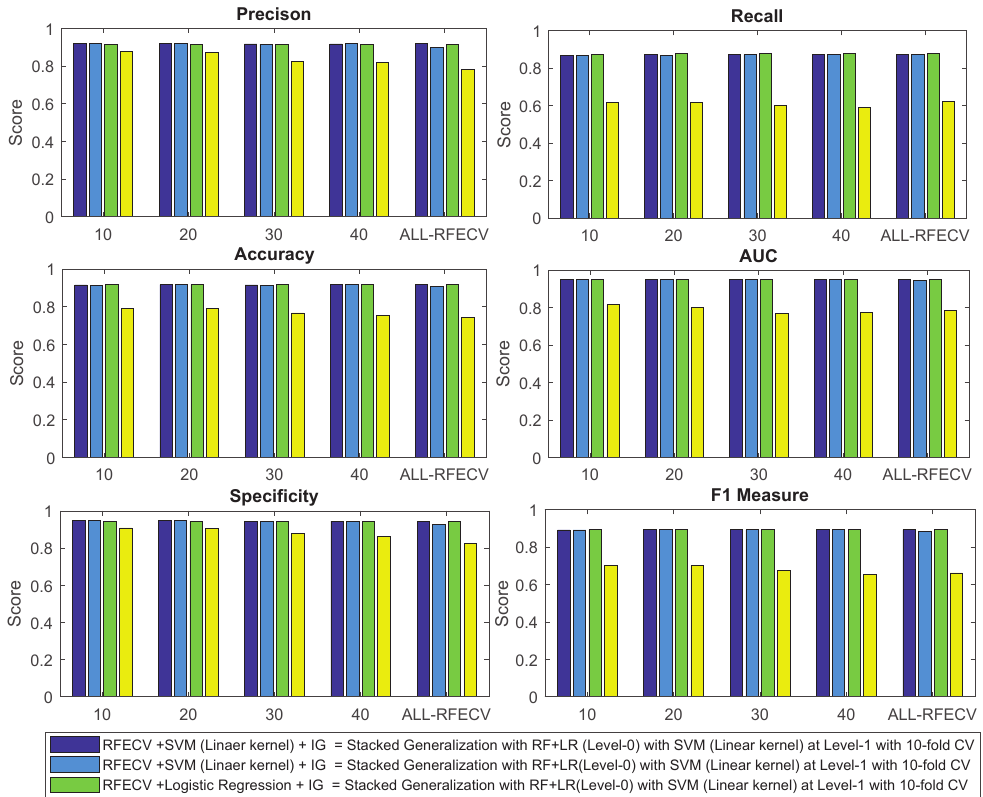
Figure 5. Comparative results of various stacked-classifiers on different features subset obtained as the result of applying GridSearch (for parameters tuning), RFECV feature selection scheme, Information Gain (IG) feature selection scheme for ranking of features, and Stacking to extract new features and to eliminate classifiers generalization